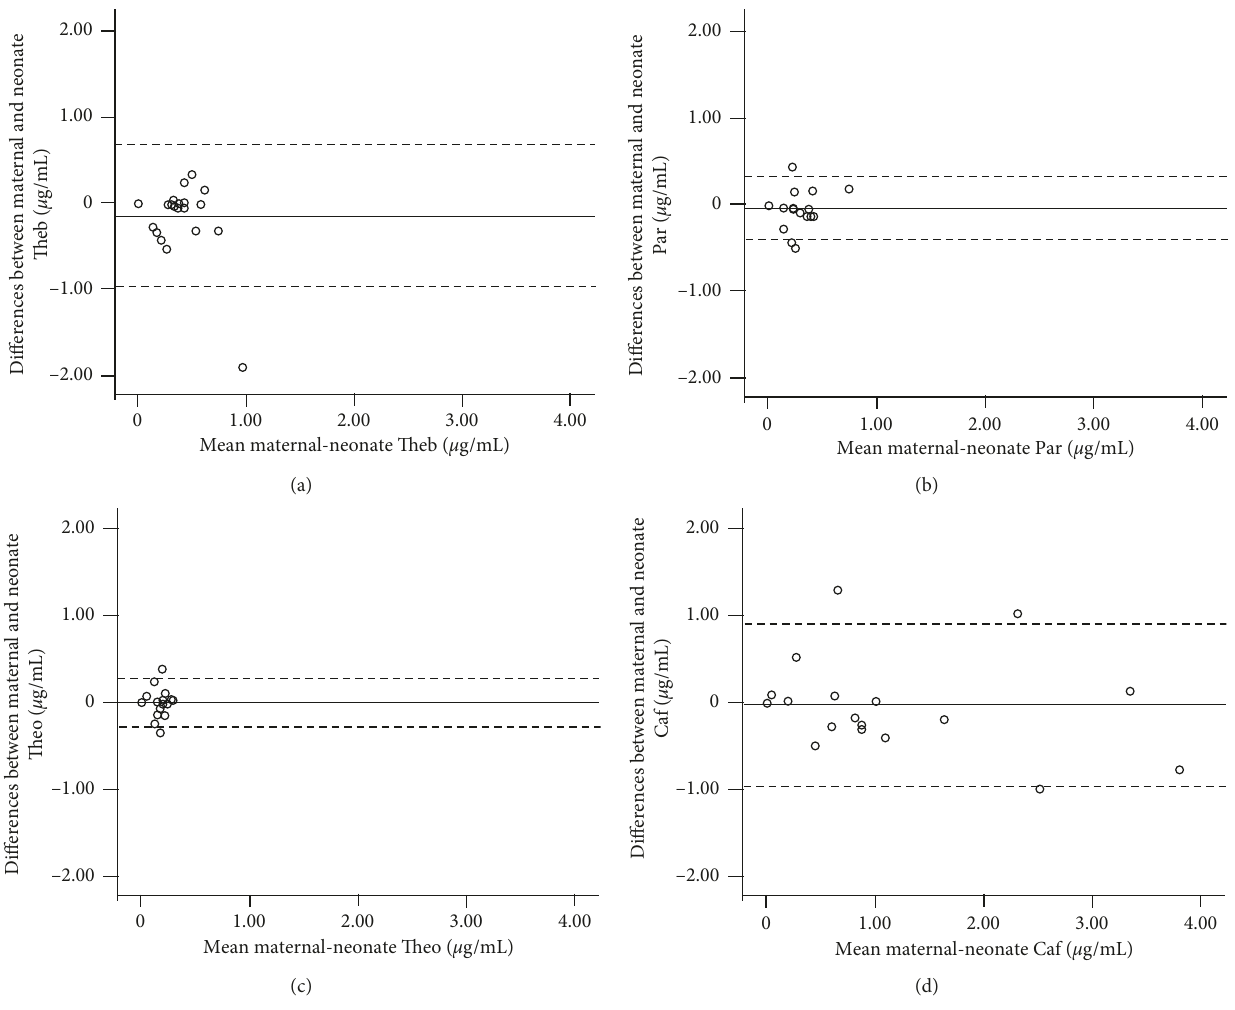
Figure 4: Bland-Altman plot for theobromine (a), paraxanthine (b), theophylline (c), and caffeine (d) plasma concentrations for mother versus newborn samples. Differences between mother-child pairs. Continuous line represents mean of difference between maternal concentration and neonatal concentration for each analyte. Dotted lines represent lower and upper limits of 95% confidence interval. Theb: Theobromine, Par: paraxanthine, Theo: theophylline, and Caf: